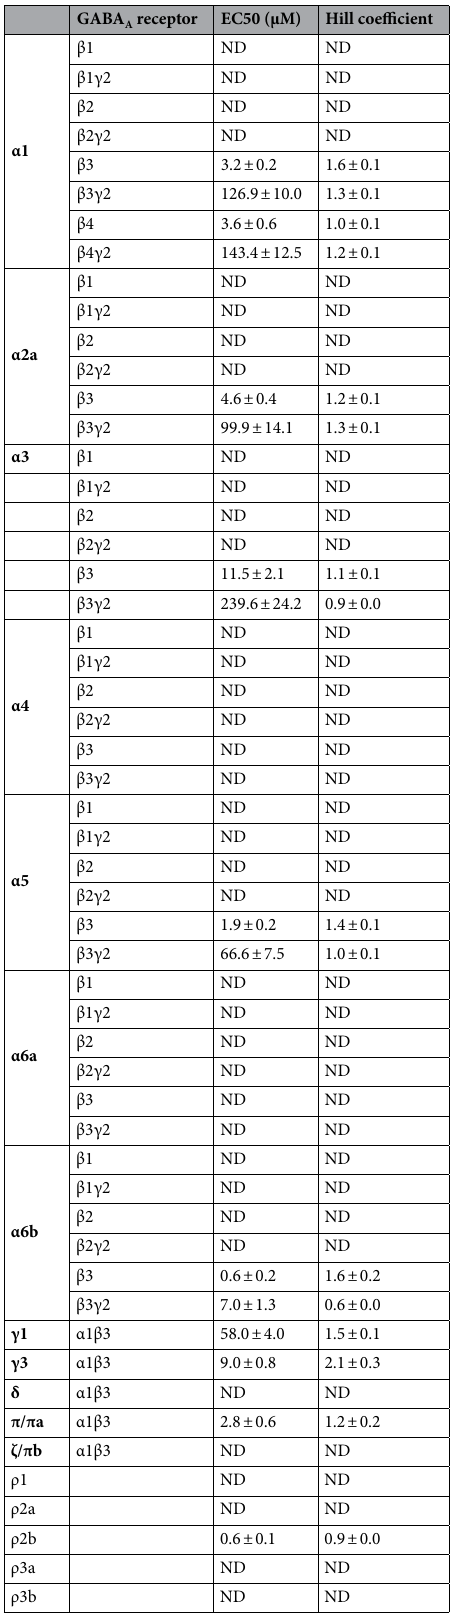
Table 2. Summary of the gating properties of zebrafish GABA A receptors. Values represent the mean ± SEM. ND: the maximum current smaller than 200 nA and, thus, not